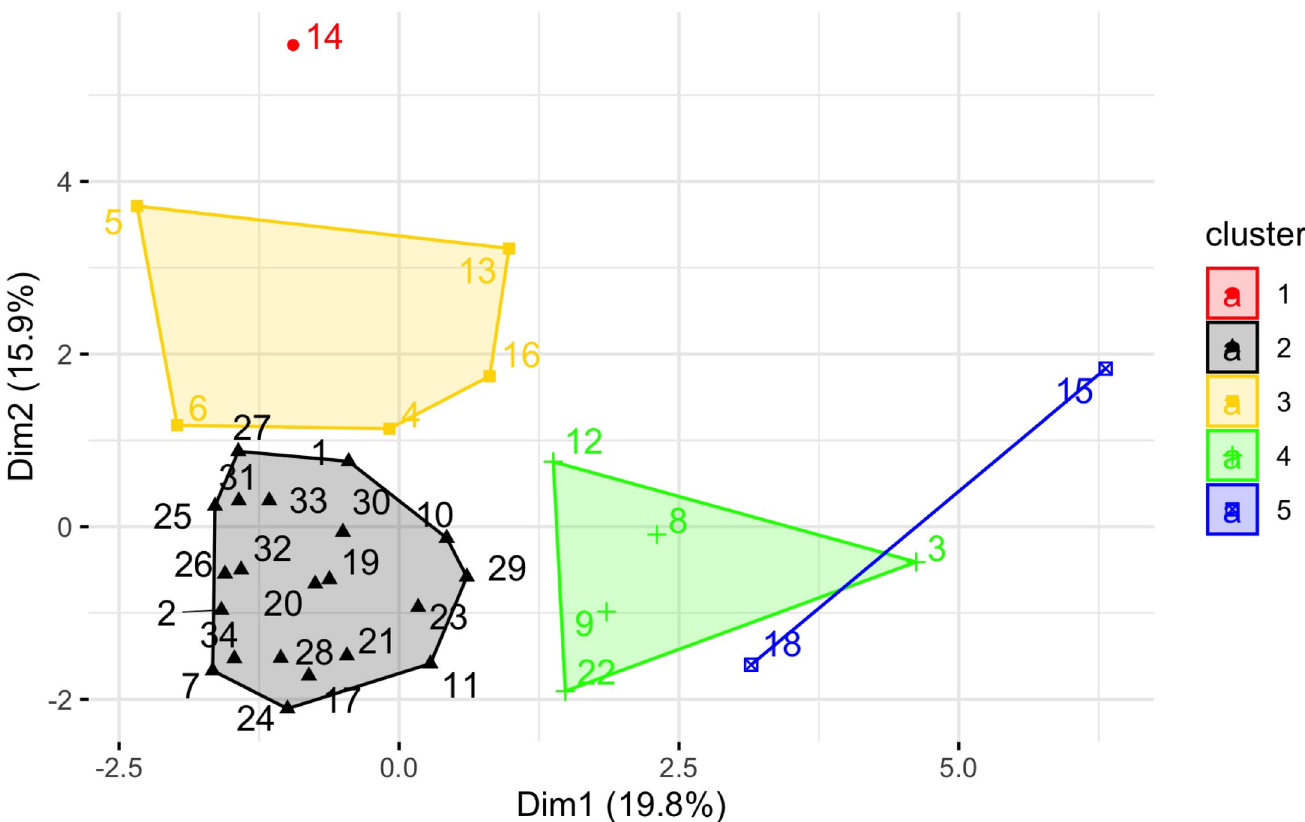
Fig 3. Clustering output from hierarchical clustering of principle components (HCPC) procedure. Two-dimensional (Dim1 and Dim2) factor map depicting the alignment of spatial bins into five distinct clusters along Principle Component axes 1 and 2, based on hierarchical clustering of the first six principle components.